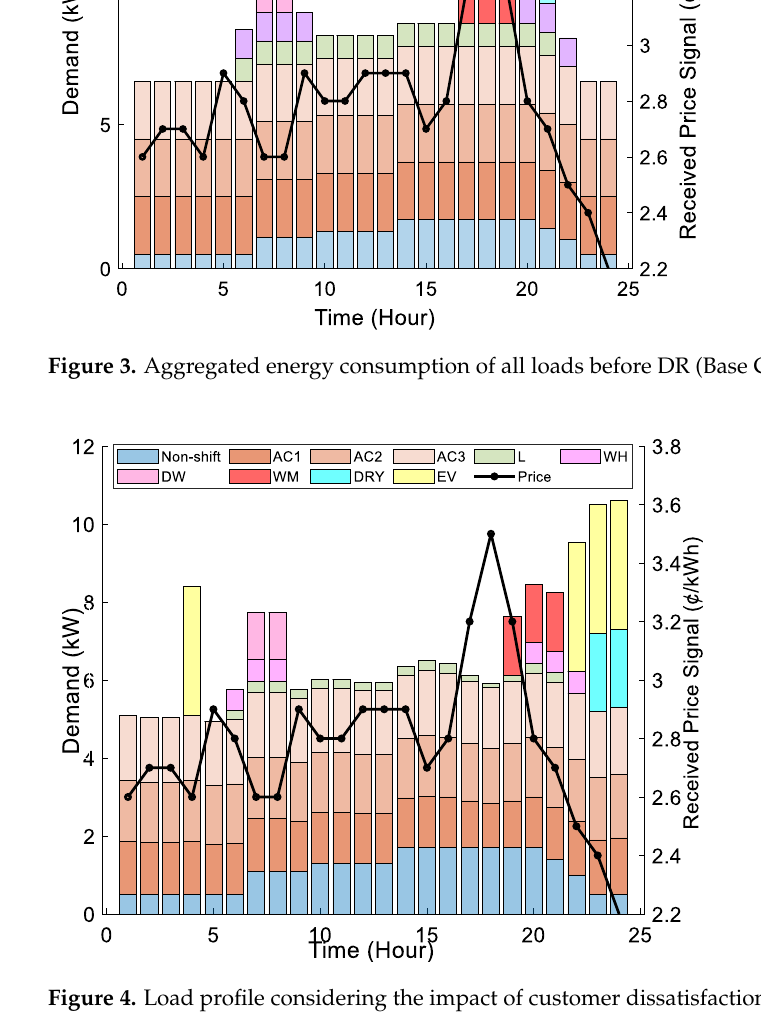
Figure 4. Load profile considering the impact of customer